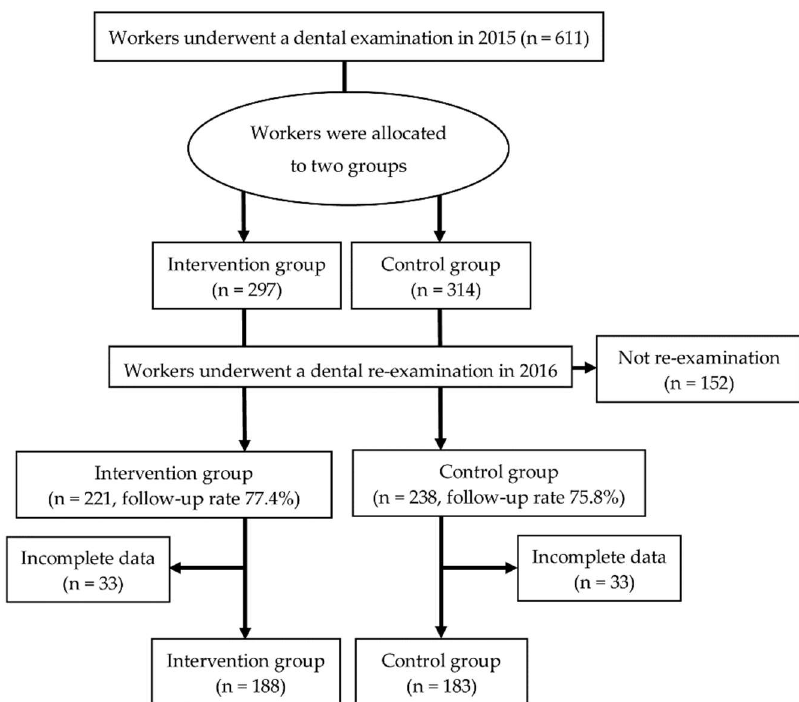
Figure 1. Flow chart showing the protocols for selecting analyzed workers from among those who agreed to participate in this study.